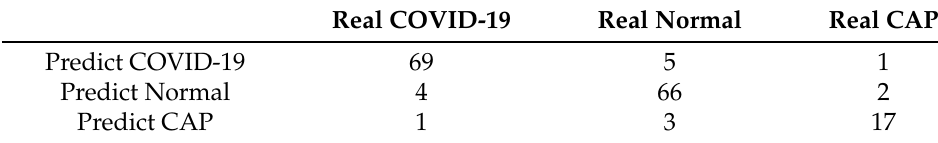
Table 12. Confusion matrix of Attention VGG16 on the X-ray Image dataset.